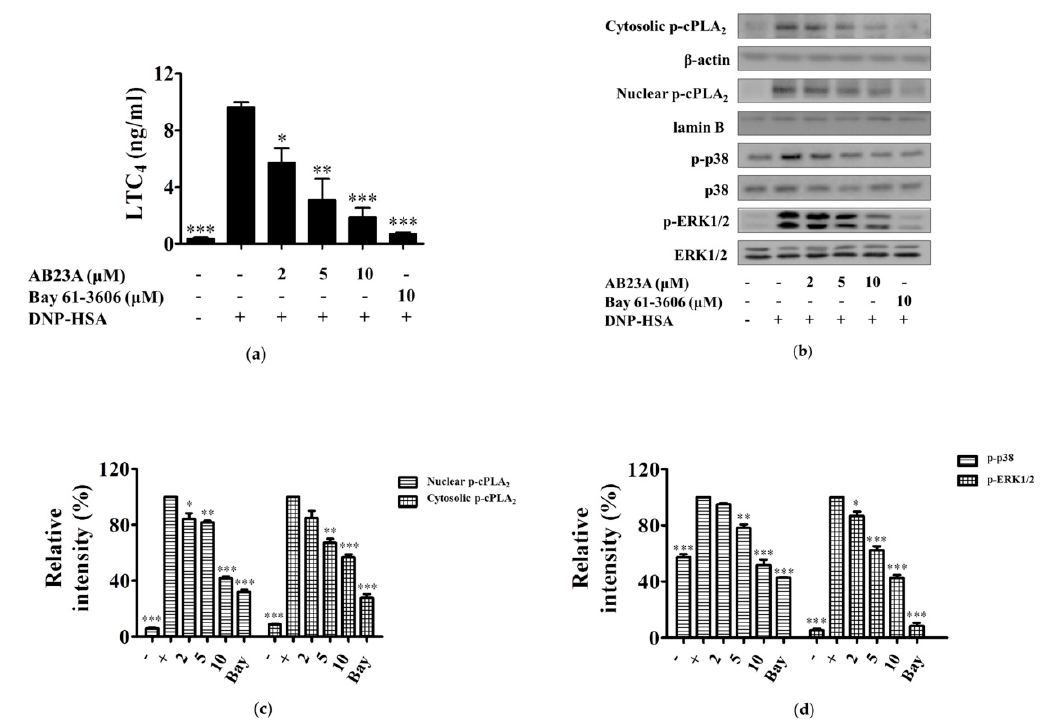
Figure 2. AB23A suppresses the generation of leukotriene C 4 (LTC 4 ), translocation of activated cPLA 2 , and phosphorylation of p38 and ERK1/2 mitogen-activated protein kinases (MAPKs). IgE-sensitized BMMCs were pre-incubated with AB23A or Bay 61-3606 for 1 h, and then stimulated with DNP-HSA for 15 min. ( a ) The culture medium was collected and measured by ELISA for the generation of LTC 4 ; ( b ) cytosolic and nuclear fractions were immunoblotted with antibodies for phospho-cPLA 2 . Additionally, total cell lysates were immunoblotted for phosphorylated and total forms of p38 and ERK1/2; ( c , d ) relative ratios of cytosolic and nuclear p-cPLA 2 proteins, p-p38 and p-ERK1/2, were measured by analyzing immunoblot band intensities. “-”: BMMCs only sensitized with IgE; “+”: IgE-sensitized BMMCs stimulated with DNP-HSA. The data show the mean ± SEM of three independent experiments. ANOVA, p < 0.0001, post hoc * p < 0.05, ** p < 0.01, and *** p < 0.001, compared with the BMMCs stimulated with IgE/Ag in the absence of